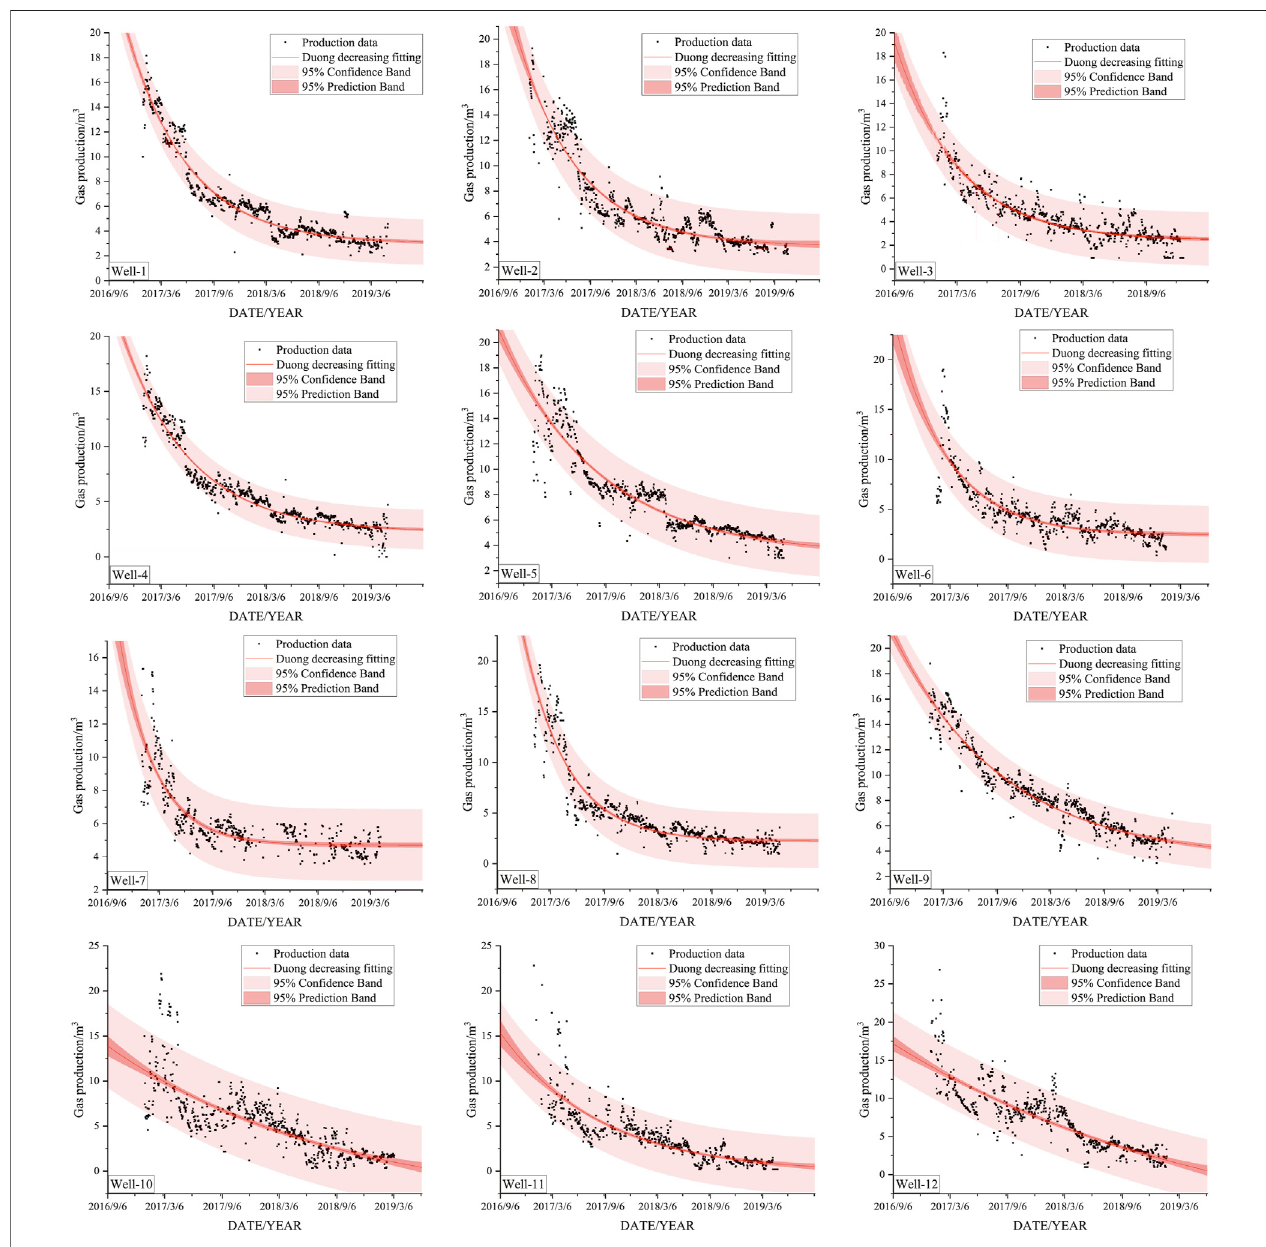
FIGURE 14 | Well production in block-A after